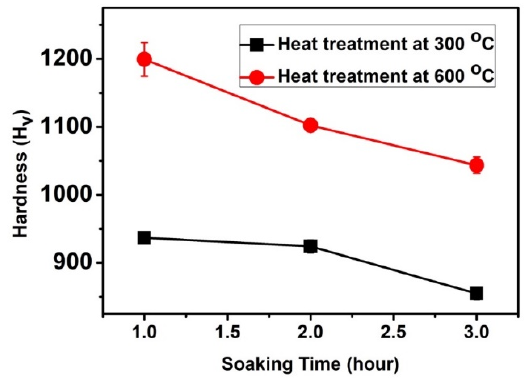
Figure 5. Effect of the soaking time of the heat treatment on the hardness of the Ni-W/B composite coatings.